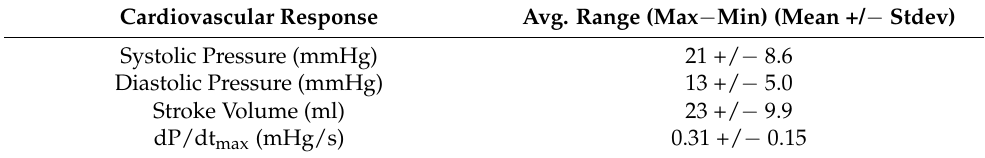
Table 4. Cardiovascular variation.